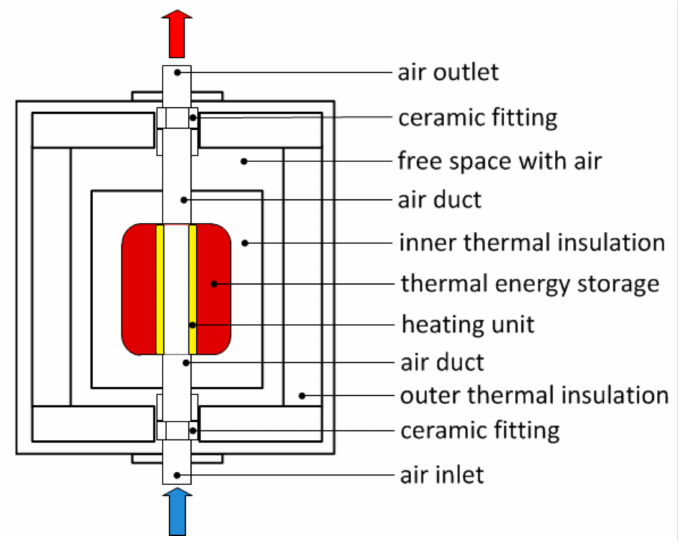
Figure 4. Schematic drawing of test bench. Component labelled “thermal energy storage” is the specimen for this study and consists of AISI 321 containment filled with mPCM